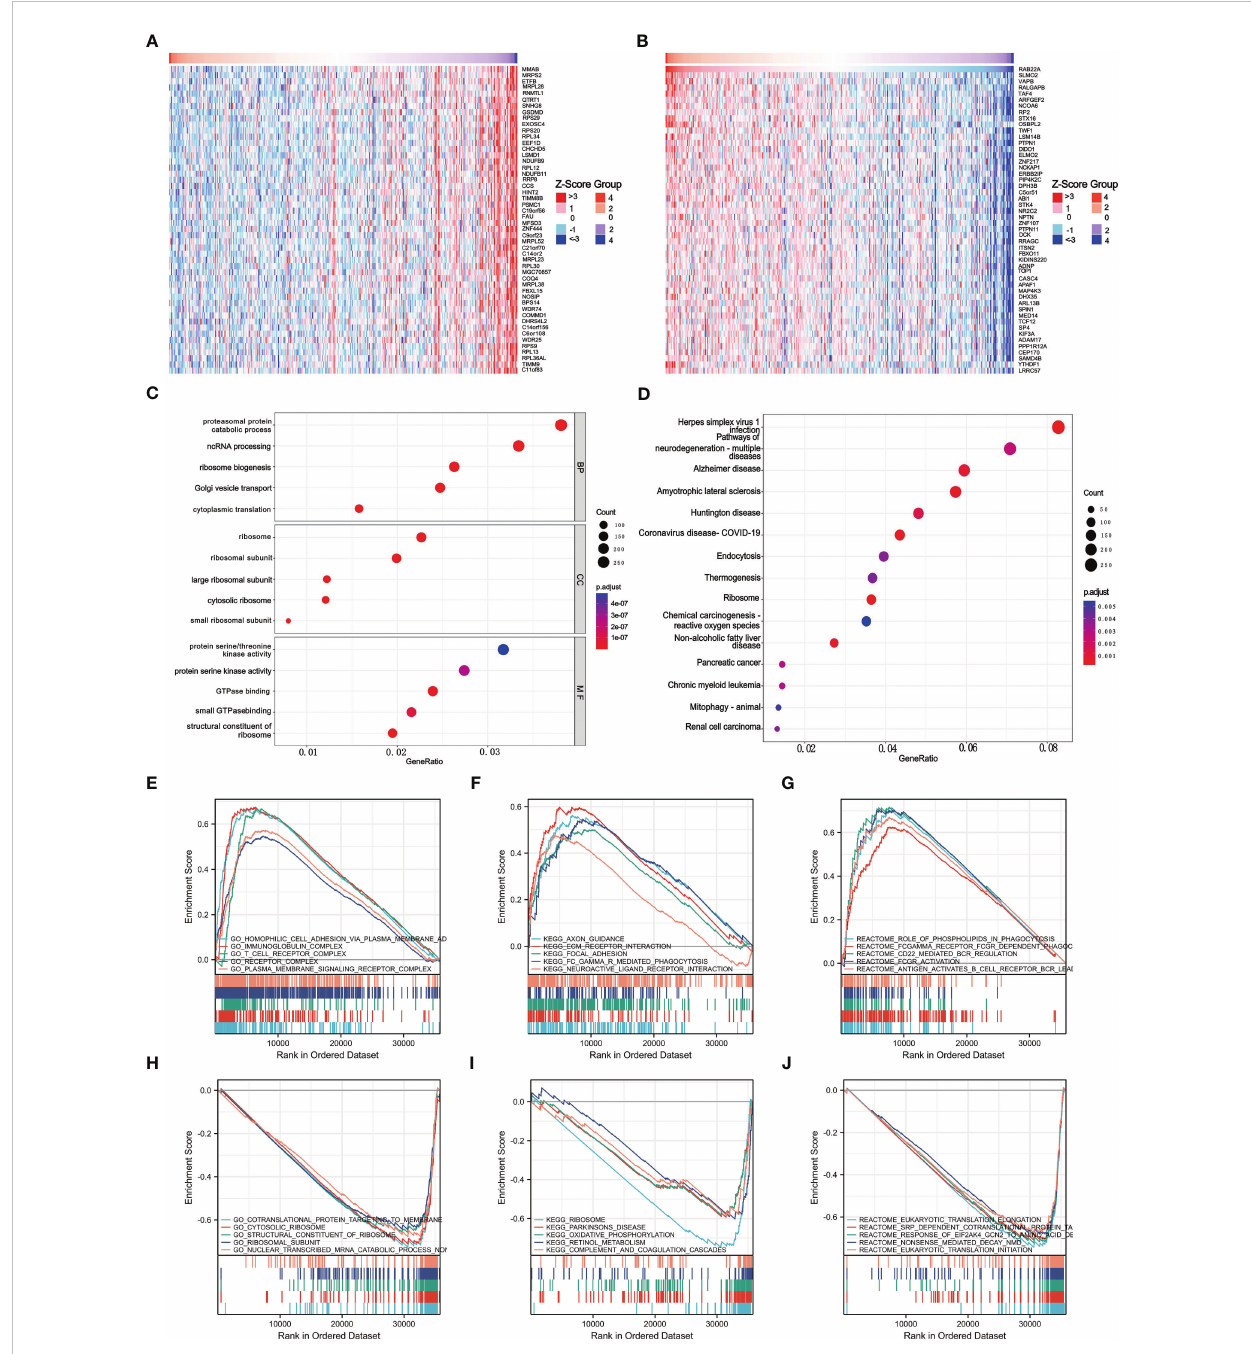
FIGURE 4 Enrichment of biofunction and associated gene analysis of RAB22A in HCC. (A, B) Heat map showing genes positively and negatively associated with RAB22A in liver cancer (top 50). Positively associated genes are indicated in red, while negatively associated genes are in green. (C) The enriched terms in GO categories in HCC. (D) KEGG pathway analysis based on RAB22A -associated DEGs. (E) The fi ve most positively correlated pathways were revealed by GO term analysis. (F) KEGG pathway analysis revealed the fi ve most positively correlated pathways. (G) The fi ve most positively correlated pathways were identi fi ed via REACTOME pathway analysis. (H) The fi ve most negatively correlated pathways were identi fi ed via GO term analysis. (I) KEGG pathway analysis identi fi ed the fi ve most negatively correlated pathways. (J) The fi ve most negatively correlated pathways were identi fi ed via REACTOME pathway